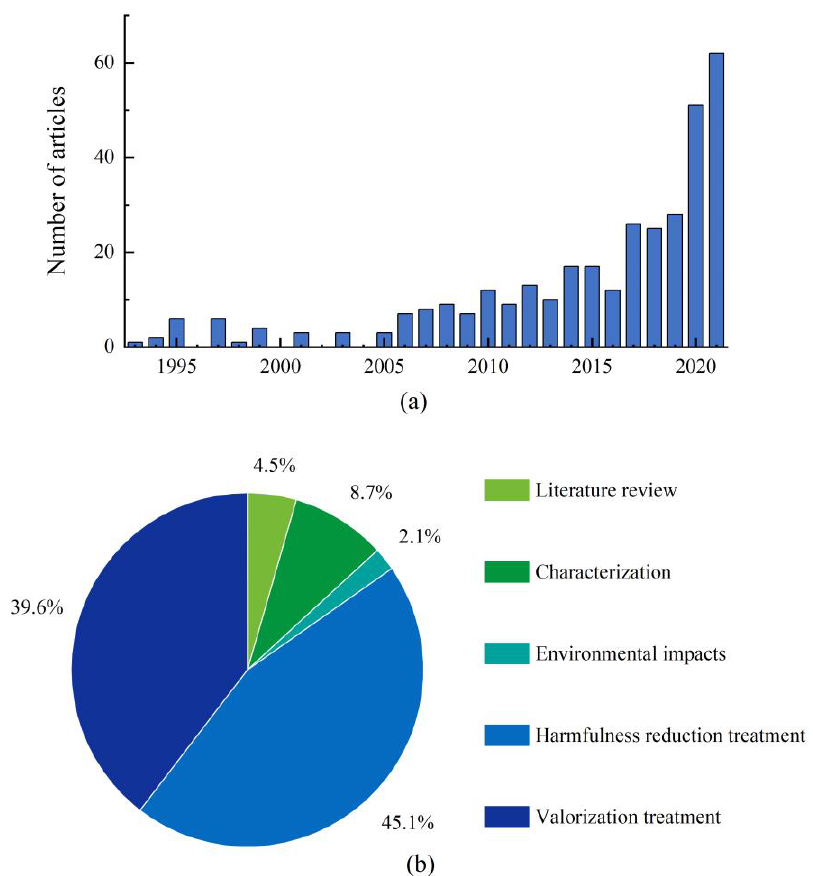
Figure 1. A graph showing the change in the annual number of oily sludge-related journal articles published from 1993 to 2021 ( a ) and a pie chart showing the percent share of 5 journal article categories based on 379 journal articles published by July 2022 ( b ).